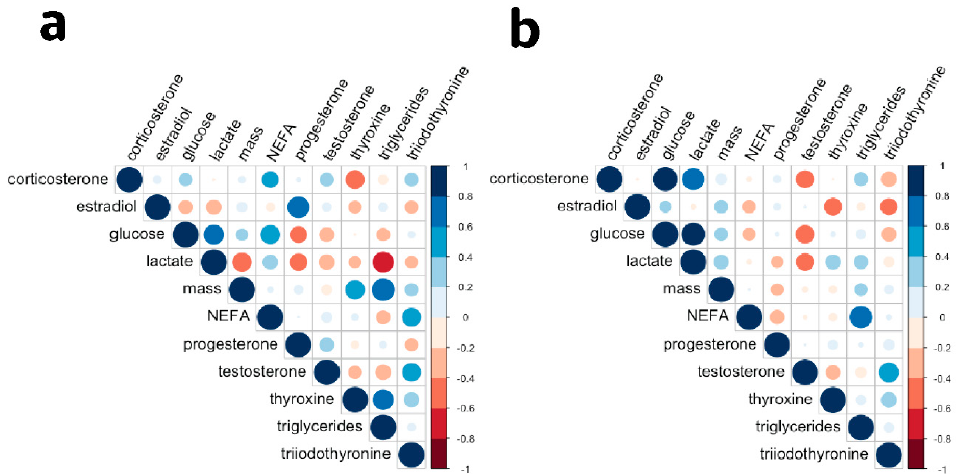
Figure 2. Correlation analysis between hormones and metabolites in ( a ) solitary and ( b ) arribada nesters.